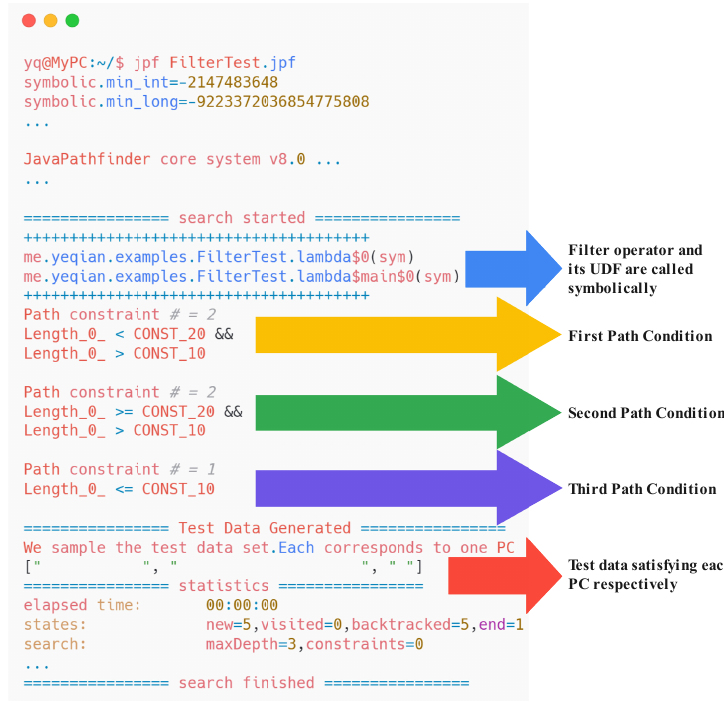
Figure 8. Symbolic analysis results for filter